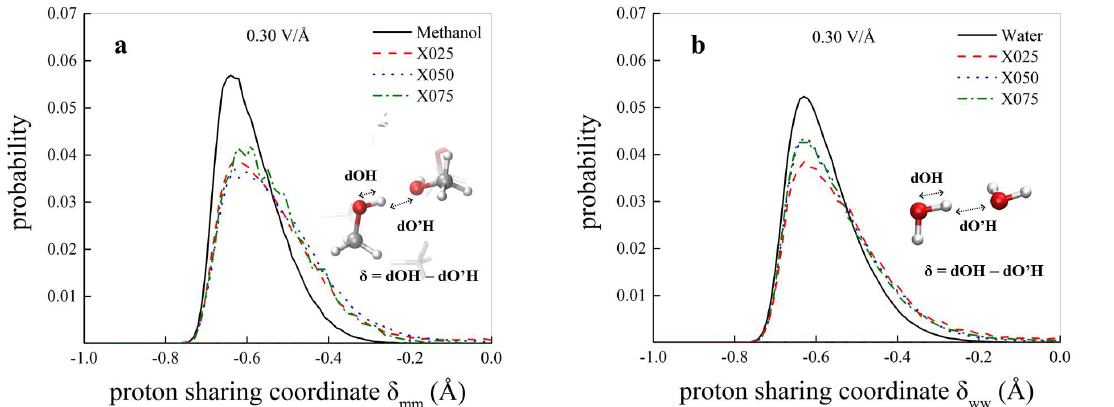
Figure 3. Probability distributions of the proton sharing coordinate δ between methanol molecules ( a ) and between water molecules ( b ) at 0.30 V/Å in neat samples (black curves) and in methanol-water mixtures at different molar fractions. In the insets, the definition of the coordinate, which is determined for every hydrogen atom in the systems involved in a tight H-bond, is